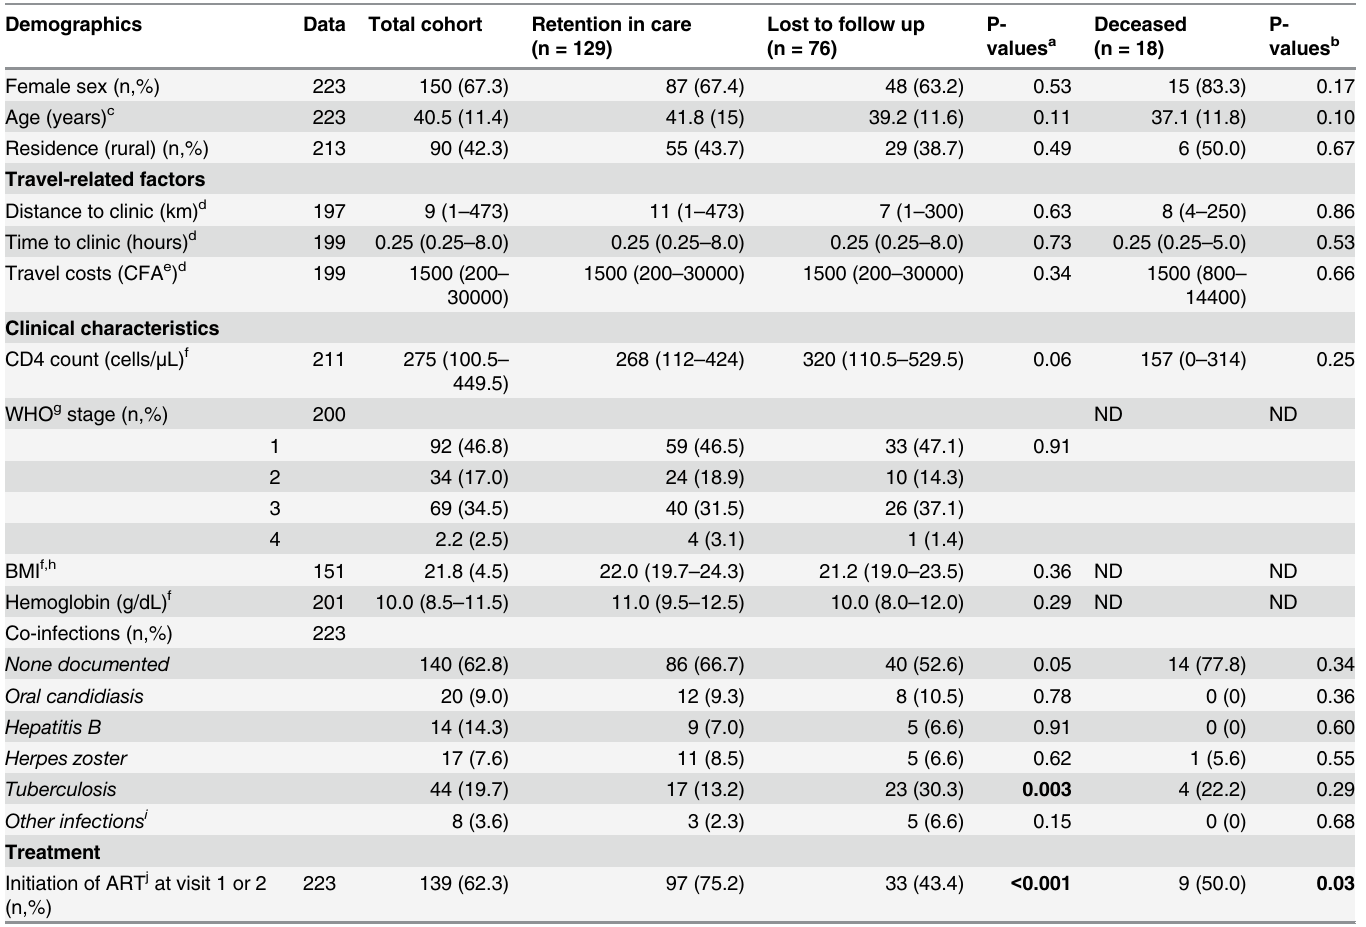
Table 1. Baseline characteristics of adult non-pregnant HIV-patients, attending the primary HIV clinic in Lambaréné, Gabon, between January 2010 and January